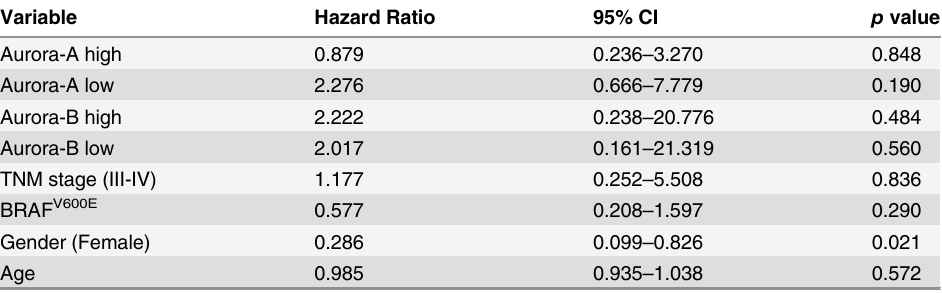
Table 3. Cox regression analysis of different variables with recurrences in PTC